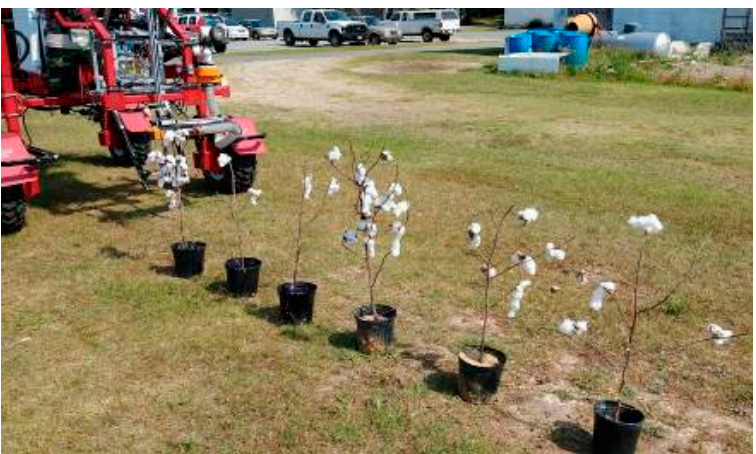
Figure 17. The experiment was set up at University of Georgia (UGA) grounds, to test the robot on picking the bolls in a simulated environment consisting of six potted cotton plants.